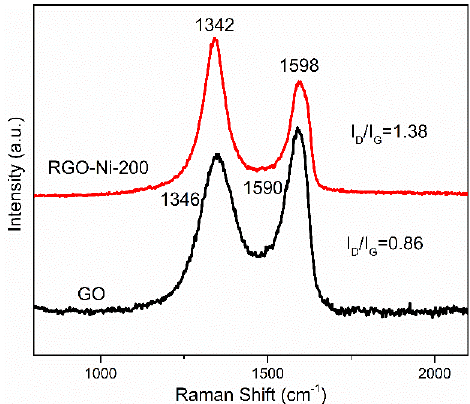
Figure 1. Raman spectra of graphene oxide (GO) and reduced GO/nickel composite irradiated at 200 kGy